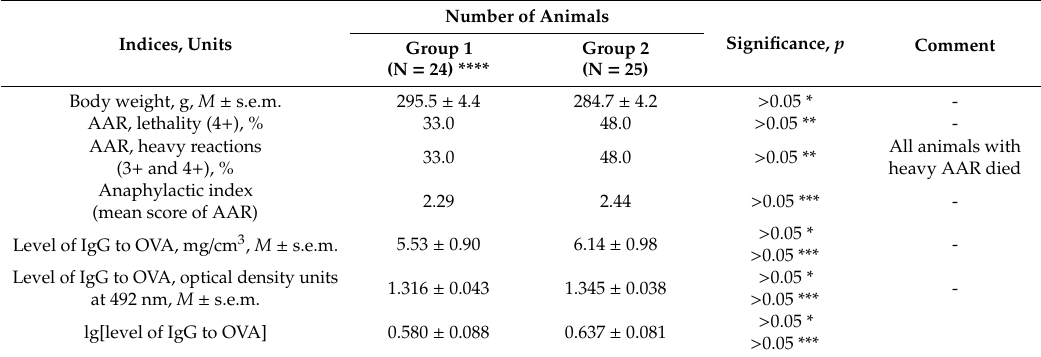
Table 4. Comparison of body weight gain, active anaphylactic reaction (AAR) indices, and antibody response in rats of groups 1 and 2 immunized with ovalbumin (OVA). Number of Animals Significance, p CommentGroup 1 Indices, Units (N = 24)